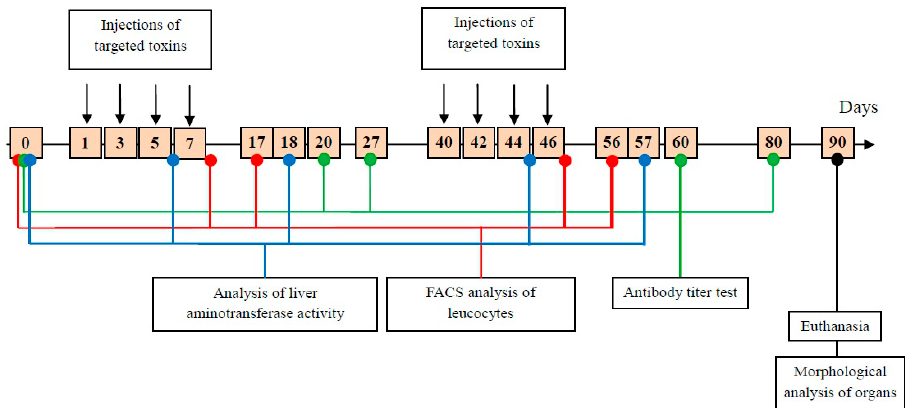
Figure 2. Scheme of the study of DARPin-LoPE and DARPin-PE40 general toxicity and immunogenicity. “0” denotes the analysis of the parameters studied in animals before the treatment course started. The day of the first injection of the targeted toxins was set as day 1. Treatment with the targeted toxins was performed in two courses of four injections every other day, with a break of one month between courses, i.e., on days 1, 3, 5, 7 (first course) and 40, 42, 44 and 46 (second course). The leucocytes were analyzed by flow cytometry on days 8 and 17 after the start of each course (i.e., on days 8, 17, 47 and 56, marked in red). The activity of alanine aminotransferase (ALT) and aspartate aminotransferase (AST) in the serum was measured on days 6 and 18 after the start of each course (i.e., on days 6, 18, 45 and 57, marked in blue). The antibody titer test was performed two and three weeks after the first treatment course ended, and two and five weeks after the second treatment course ended (i.e., on days 20, 27, 60 and 80, marked in green). Animals were euthanized on day 90, and organs were taken for histological study (marked in